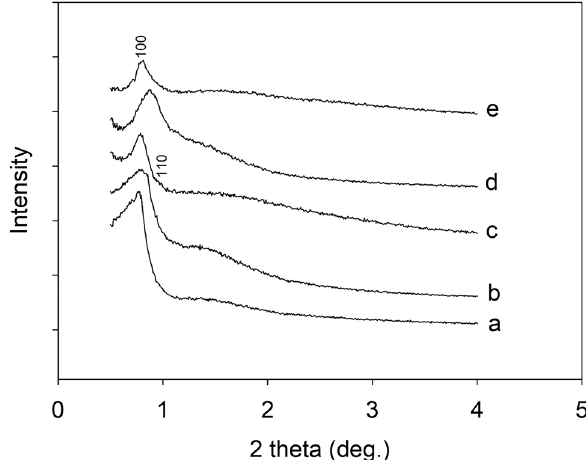
Fig. 6 Wide-angle XRD patterns of the catalysts: a B300, b BC27, c BC48, d BC5.7, e BC11.1, and f